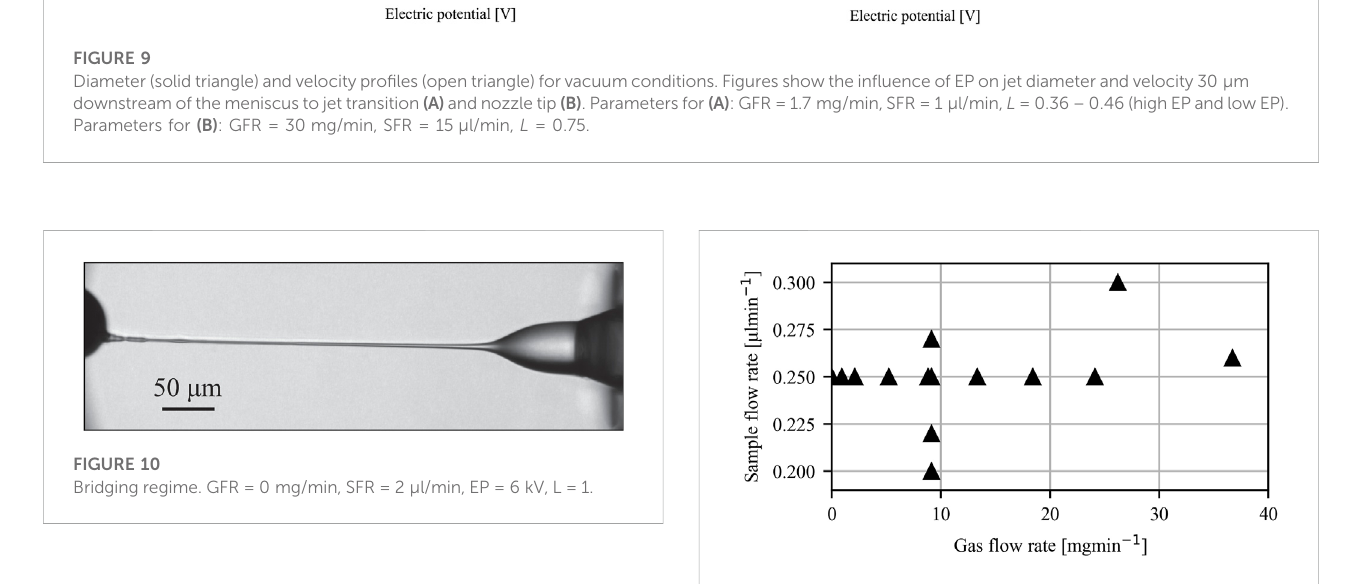
FIGURE 11 Tested parameter space where stable jetting was observed. EP = 7 kV for all